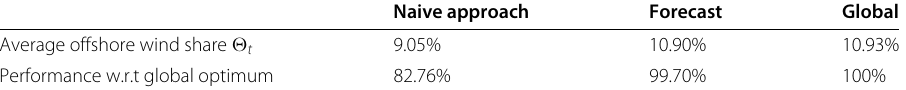
Table 5 Comparison of results for the operation strategy with regard to grid integration Naive approach Forecast Global Average offshore wind share (cid:4) t 9.05% 10.90% 10.93% Performance w.r.t global optimum 82.76% 99.70% 100%